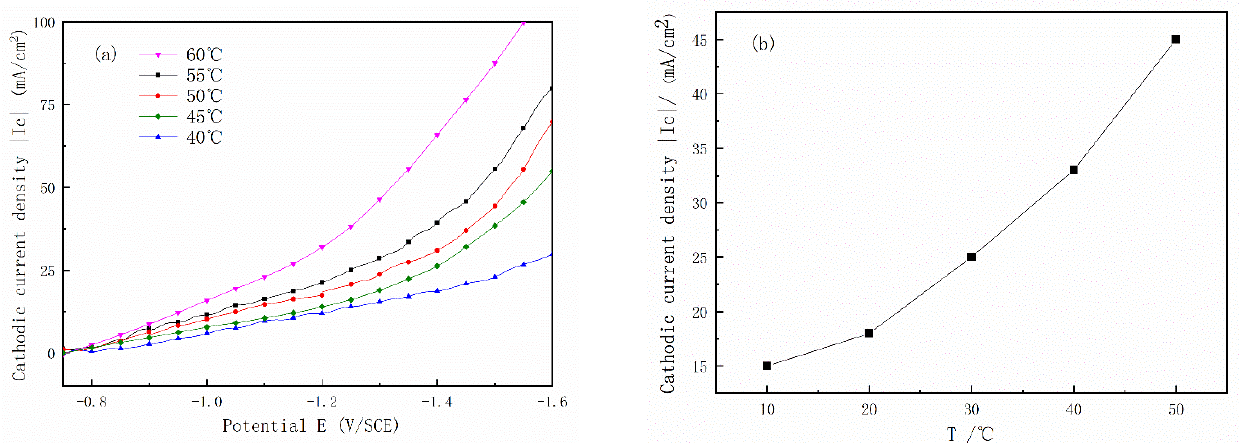
Figure 3. ( a ) Cathodic polarization curves of 0.06 M Fe 2+ at di ff erent temperatures and pH 2.5; ( b ) The relationship between the temperatures and the cathodic current density |Ic| when the potential is − 1.2 V in Figure 3a.